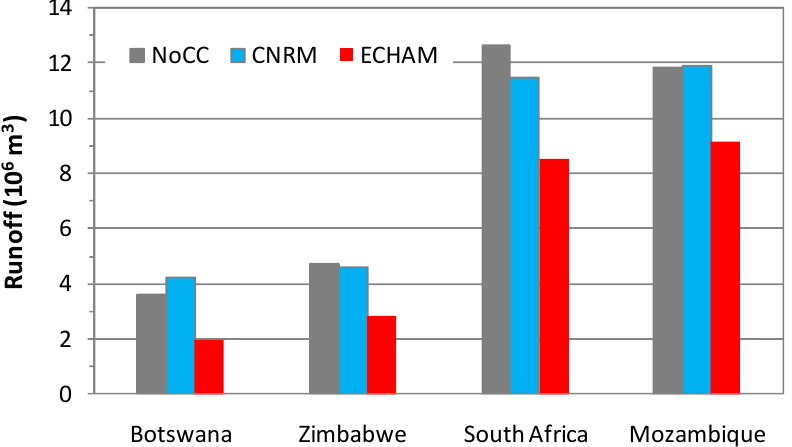
Figure 12. Mean annual runoff under the 1971–2000 historical climate and climate change scenarios for